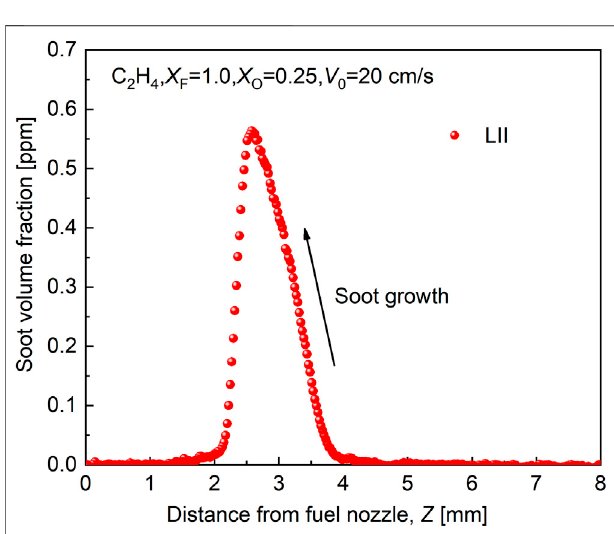
FIGURE 4 | The soot volume fraction pro fi le at the axis measured by calibrated